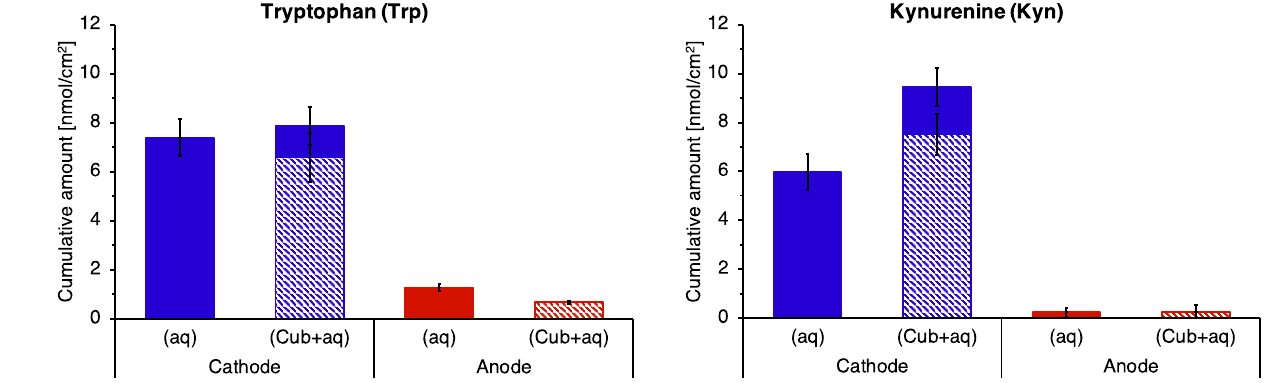
Figure 5. Cumulative Trp and Kyn extraction in 6 h of reverse iontophoresis into the cubic matrix (Cub+aq) and compared to that when an aqueous pH 7.4 solution was used as before. The data presented are mean ± SEM ( n = 3 and 5 for extraction into the cubic matrix at anode and cathode, respectively; n = 6 for extraction into aqueous solution).